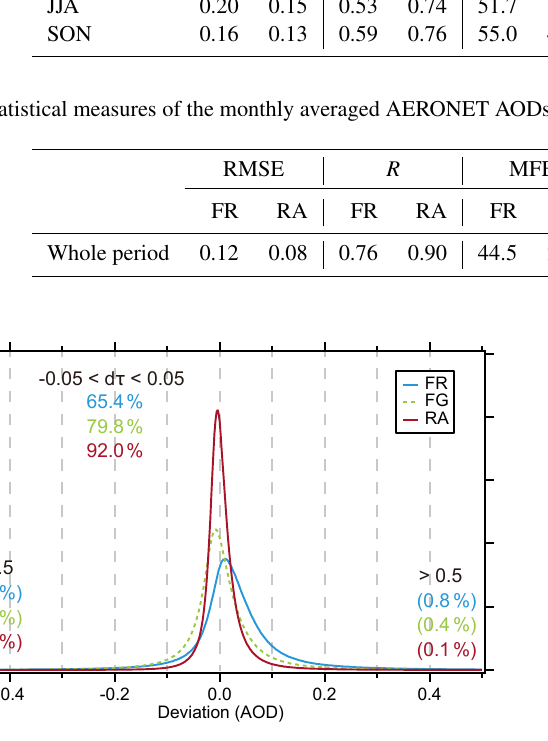
Figure 11. Scatter plots of (a) FR and (b) RA AODs versus 1h binned AERONET AODs for the whole reanalysis period (2011–